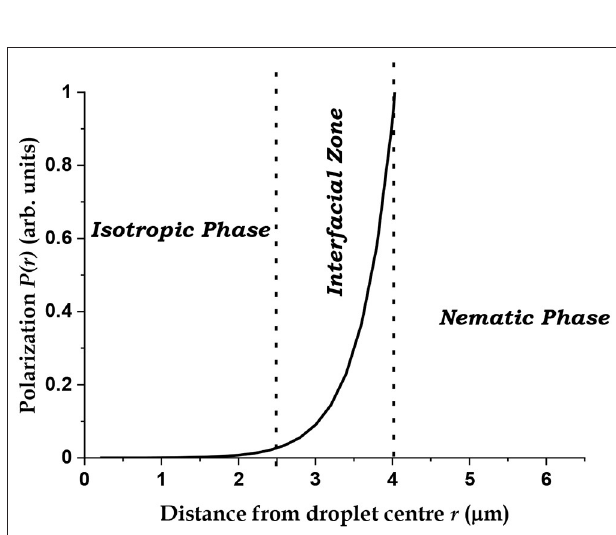
FIGURE 7 | Calculated average polarization profile of the EMIF-MBBA open system based on Equation